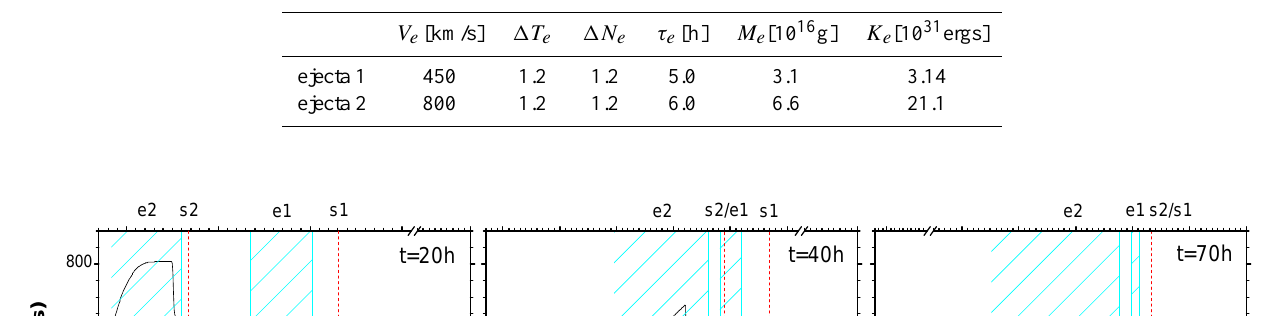
mp · N(r i ) · dϑ(r i ) ) and i = 1